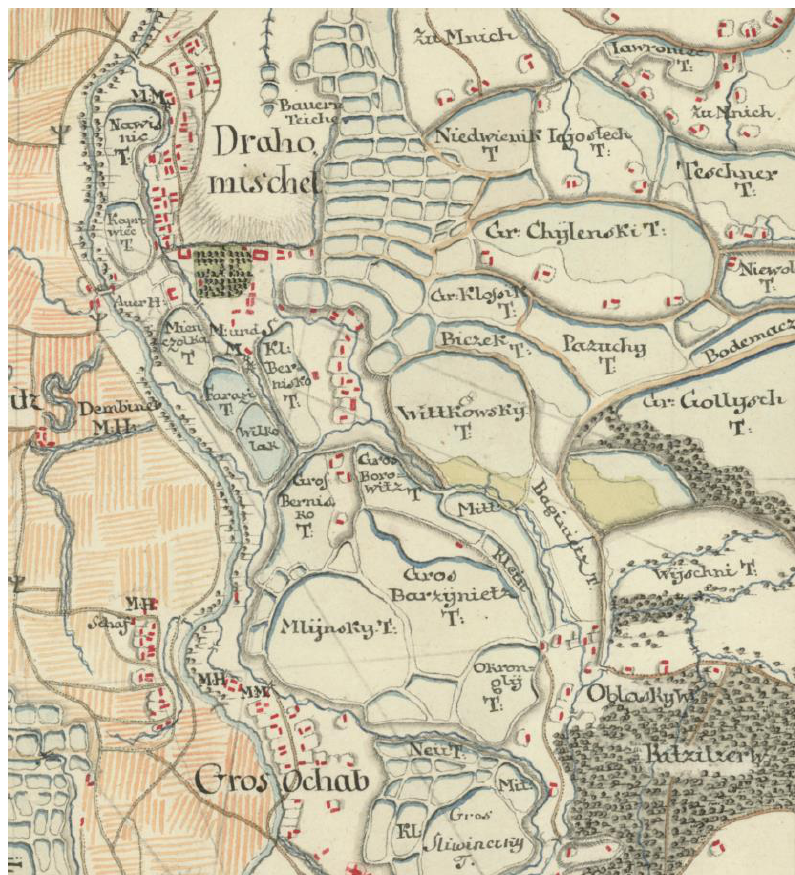
Fig. 4. A complex of several dozen ponds in the area of the Drogomyśl and Ochaby Wielkie settlements, 1763–1764 (according to General Mappa des …, 1763–1764, original scale ca. 1:28,800)